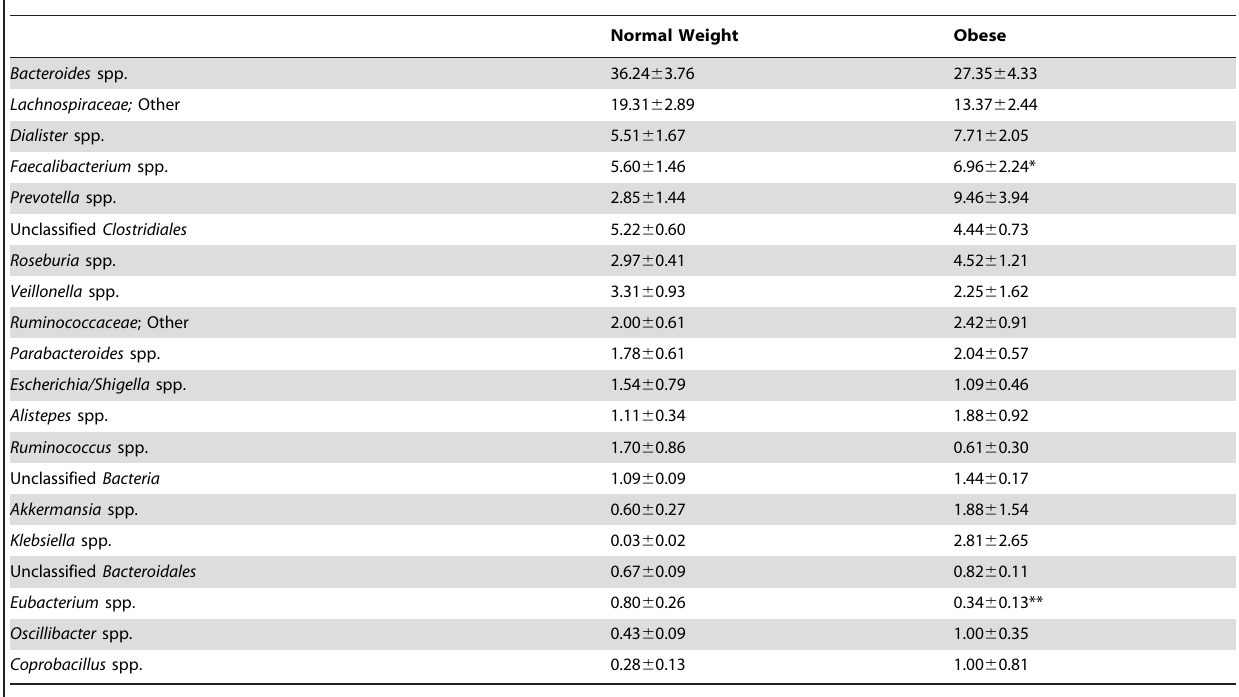
Table 3. Top 20 Most Abundant Genera.